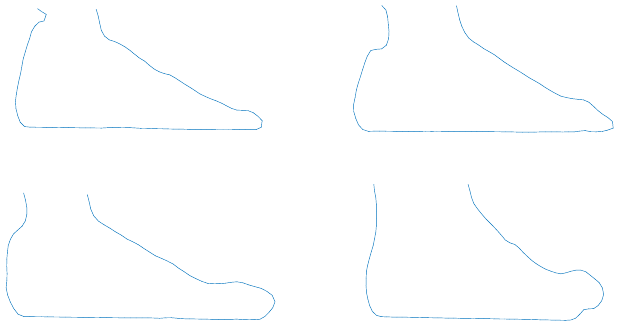
Figure 11. The most outlier feet for men ( first row ) and women ( second row